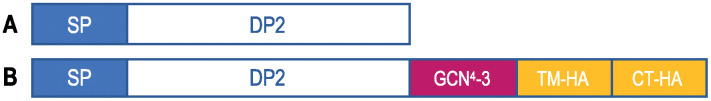
Schematic representation DNA encoding fusion protein used in this study.For construct aimed at producing supramolecular assemblies, a TM-HA/CT-HA domain from influenza hemagglutinin H5N1 (accession number: ABW06108.1), was fused at the C-terminus of the Der p 2 allergen (DP2).